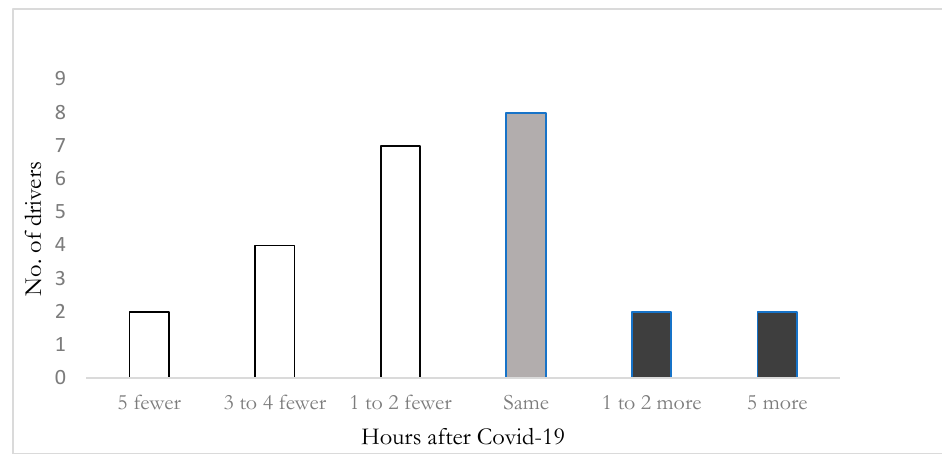
Figure 4. Change in drivers’ working hours since COVID-19 ( n = 70).